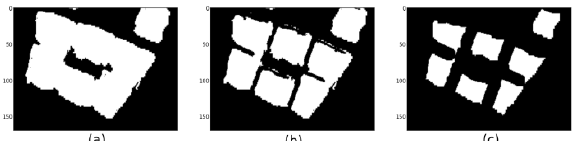
Figure 6. (a) Initial building candidate areas. (b) Building candidate areas after exclusion of shadow regions. (c) Building candidate areas after erosion.